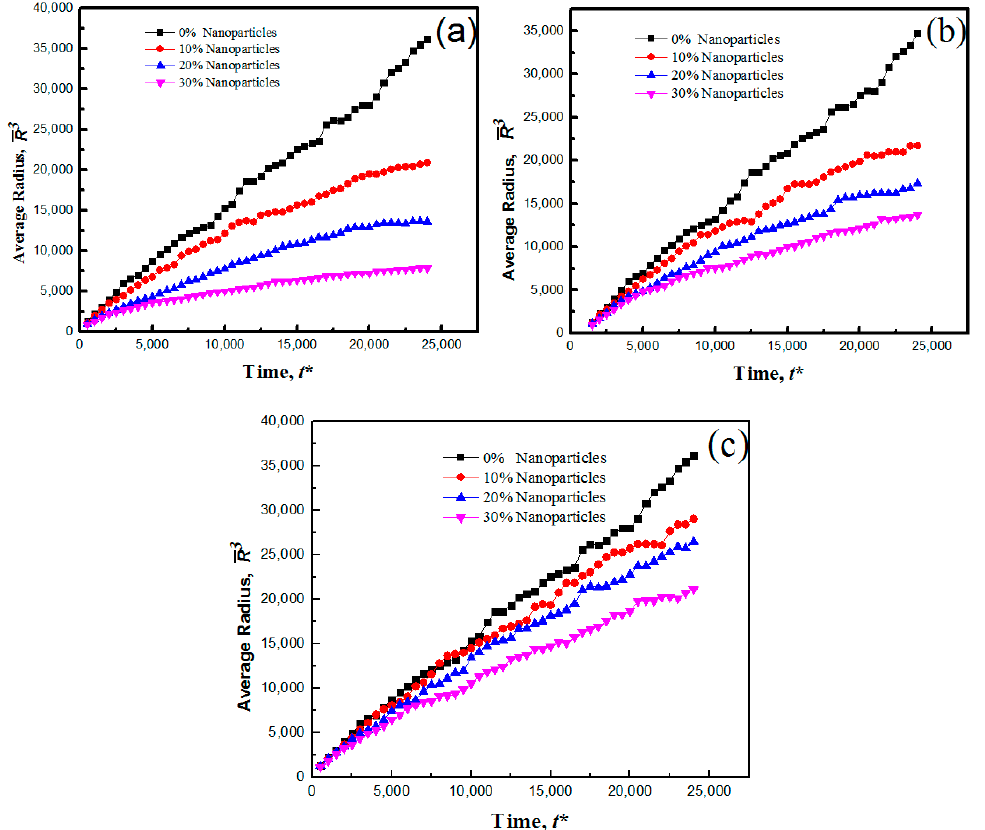
Figure 6. Plots of the cube of the average precipitate radius versus time. Nanoparticle area fractions are labeled in the figures. Nanoparticle sizes are: ( a ) 10, ( b ) 20 and ( c ) 30. The PSD at different times in presence of nanoparticles of radius size r * = 10 with